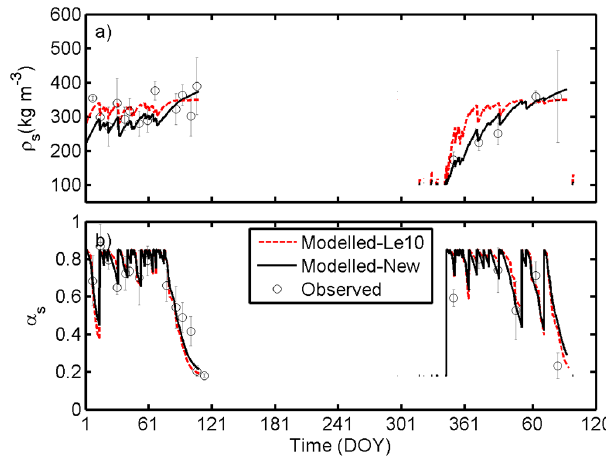
Figure 4. Observed and modelled (a) snow density ( ρ s ) and snow albedo ( α s ) at the suburban site in Montreal (January 2008– April 2009). Observed values are the medians from four locations and the error bars show the quartile deviations. Aging functions pro- posed in Lemonsu et al. (2010) “Le10” and in the current study